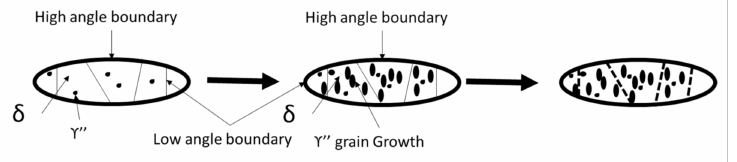
Figure 12. The γ ” grain deposition and the δ phase refinement in the GH4169